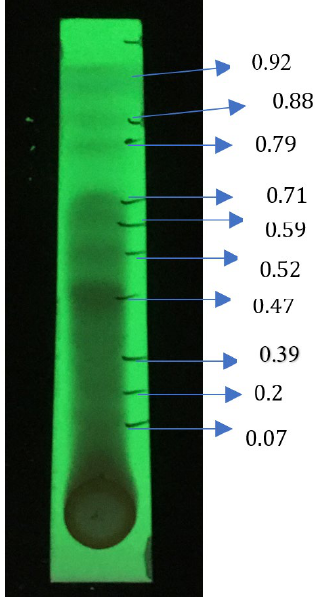
Fig. 7. Chromatogram of acetone extract of T.catappa leaf eluted wih Ethyl acetate, Methanol and Water solvent system ( 40:5.4:4) showing clear seperation of phytocompounds. Table 1. Minimum Inhibitory and Minimum Bactericidal Concentration and of acetone